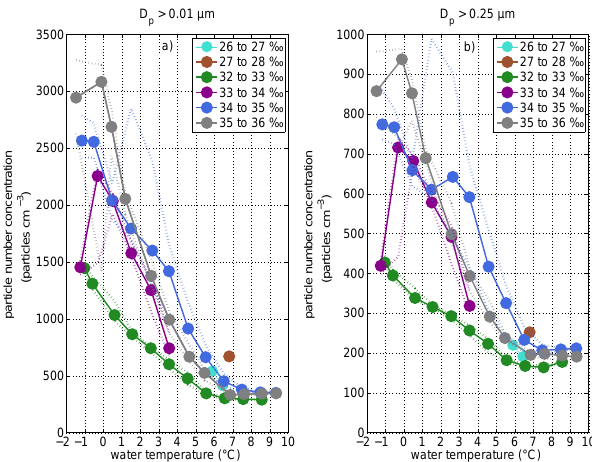
Fig. 8. Median particle number concentration dependence of salin- ity for different water temperature bins. Dashed lines represent 25th and 75th percentiles. (a) Medians of total particle number concen- trations for particles with a D p > 0 . 01µm. (b) Medians of total par- ticle number concentrations for particles with a D p > 0 .